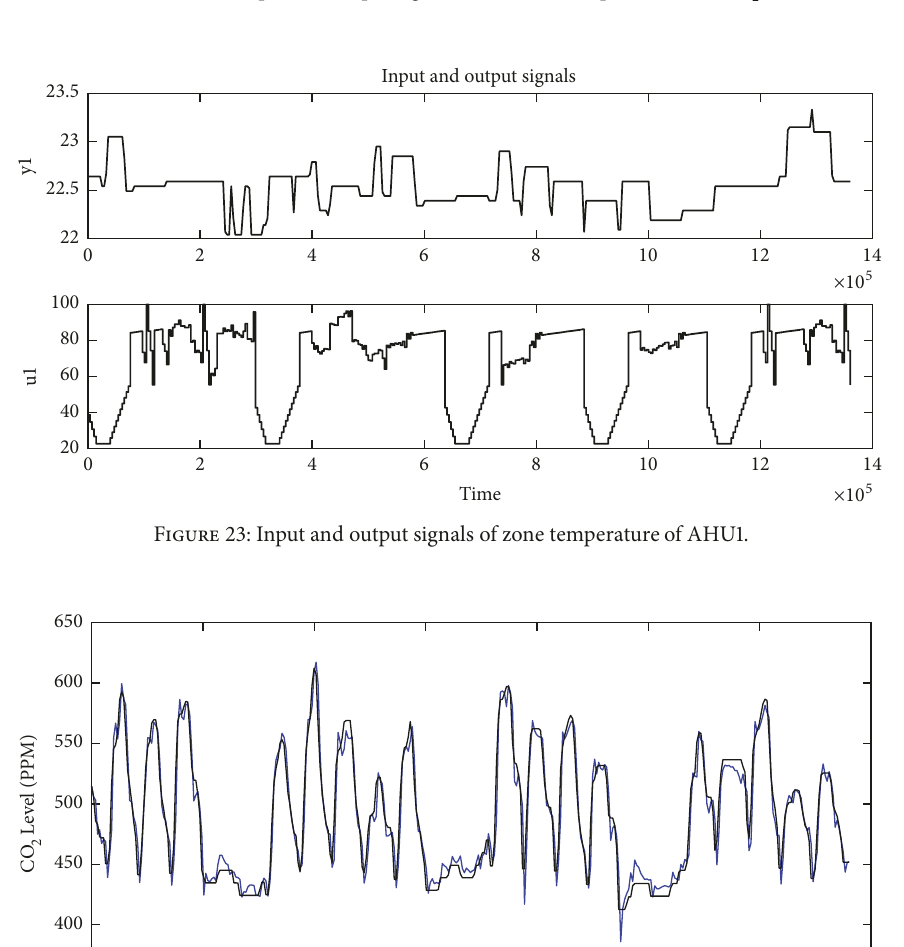
Figure 22: Input and output signals of the static air pressure of AHU 2 .